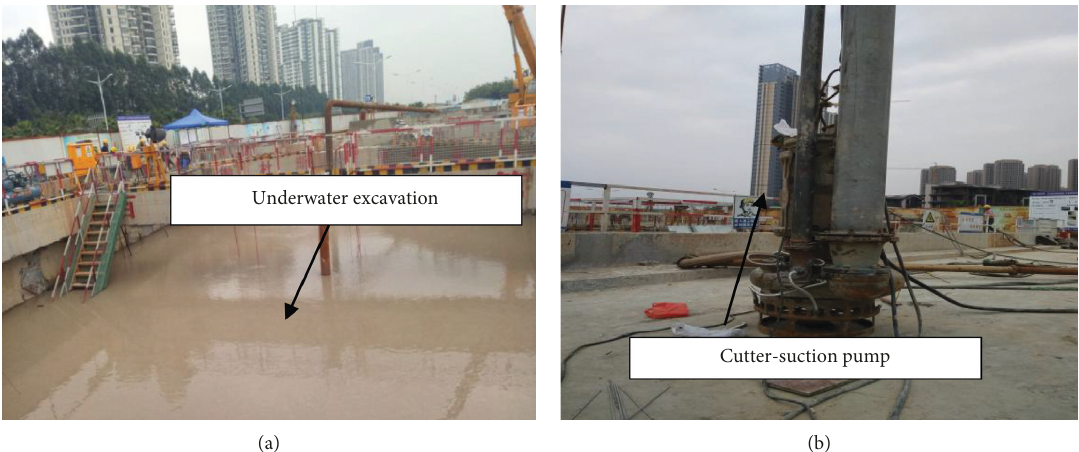
Figure 8: Construction of underwater excavation. (a) Underwater excavation without drainage. (b) Cutter-suction